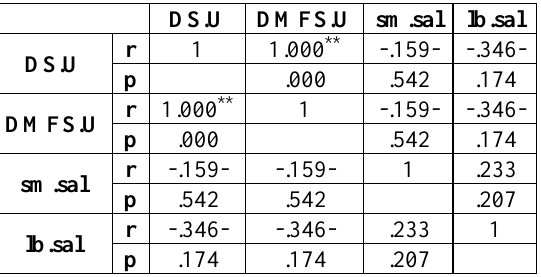
Table 2: The descriptive statistics for the colony forming units of streptococcus mutans and lactobacilli